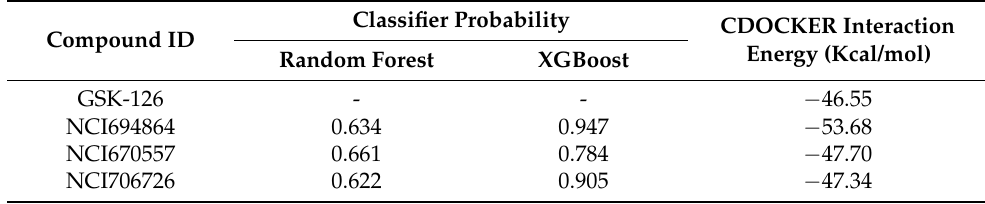
Table 4. List of selected hits from NCI